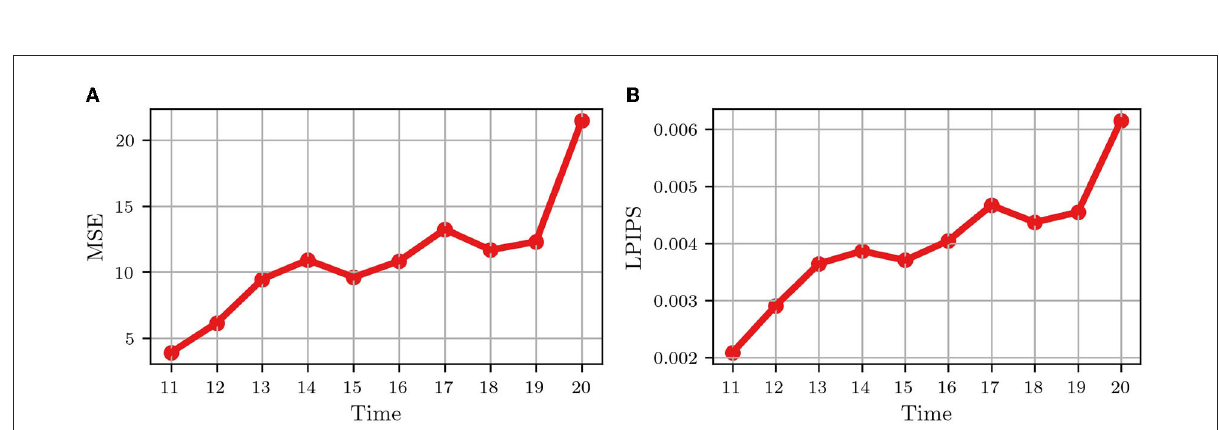
FIGURE5 Quantitative comparison between the groundtruth and the predicted frames for the test wells in Figure 1. (A) Average mean-squared error (MSE) for all test wells; (B) Average learned perceptual image patch similarity (LPIPS) for all test wells. Each dot represents a